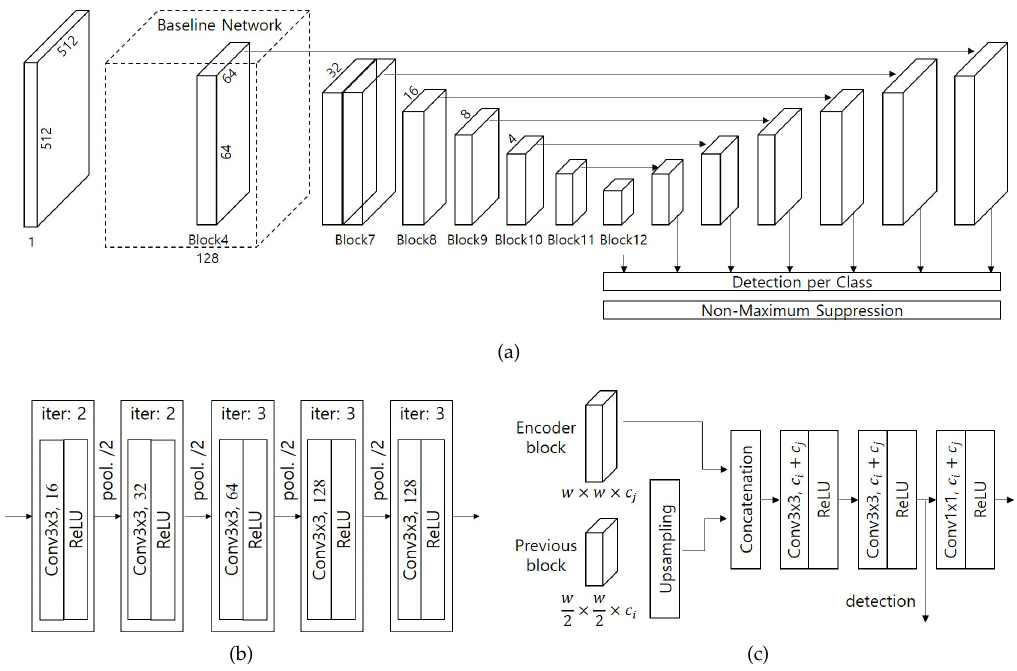
Figure 6. Network architecture of the proposed system: ( a ) overall network architecture; ( b ) baseline network using the VGG model; and ( c ) decoding block for object detection.